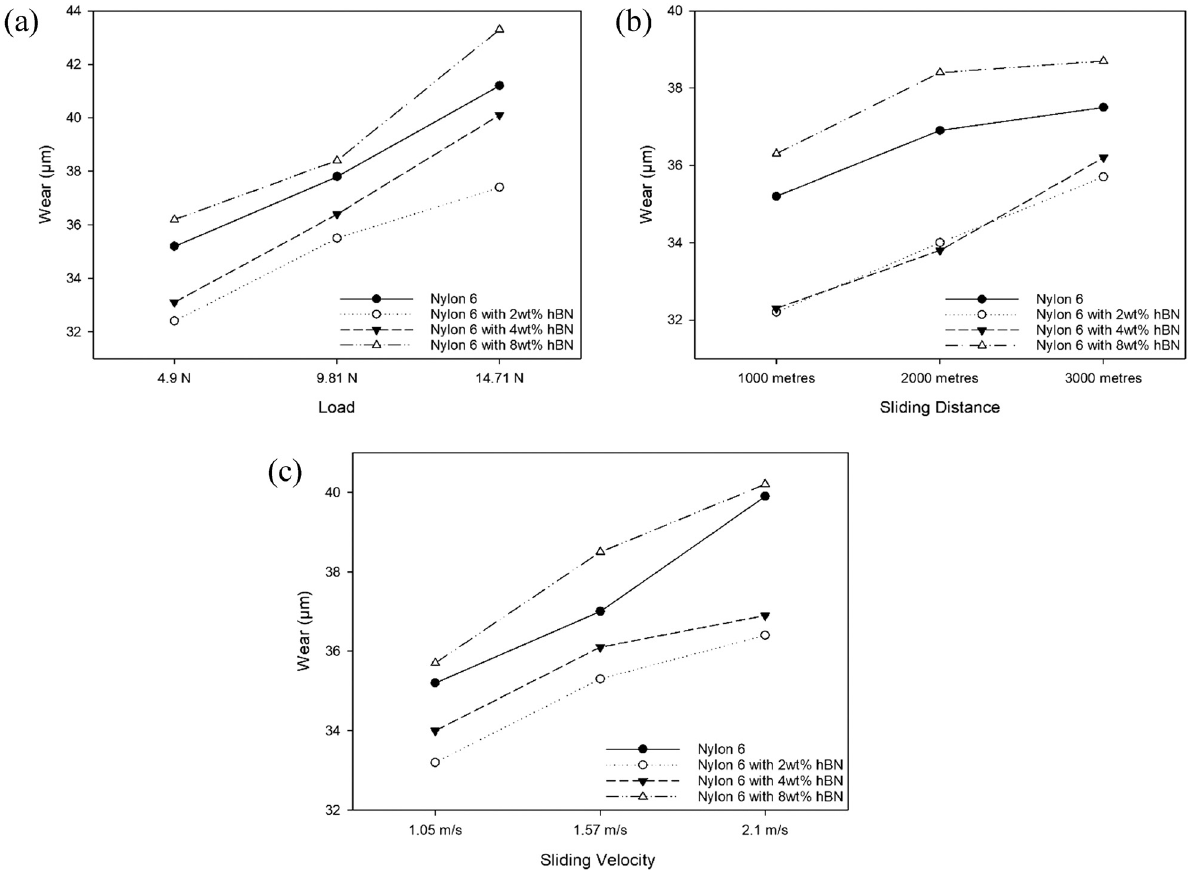
Figure 9: Wear vs ( a ) di ff erent loads, ( b ) sliding distances, and ( c ) sliding